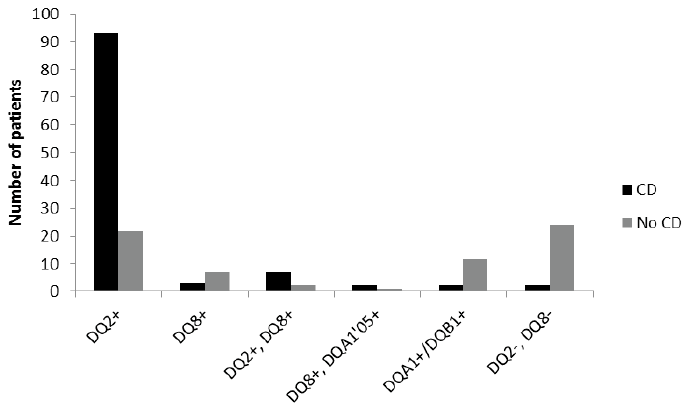
Figure 2. Number of children with celiac disease (CD, n = 109, black) and control children (No CD, n = 68, grey) with the different human leukocyte antigen (HLA)-types.